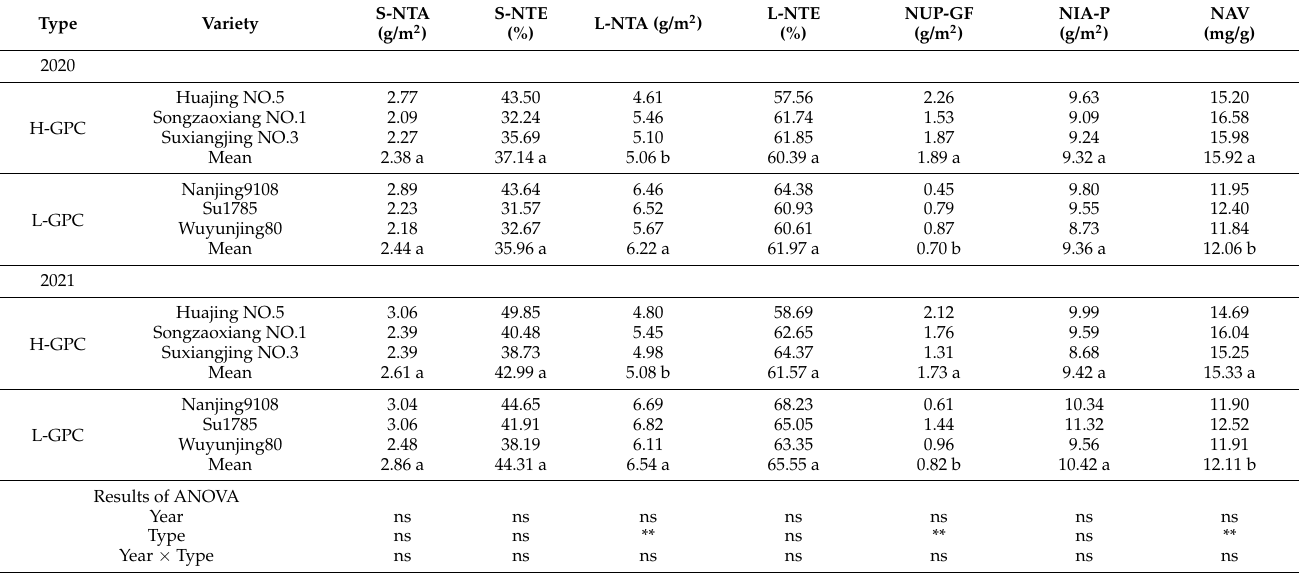
Table 5. Nitrogen transport during grain-filling